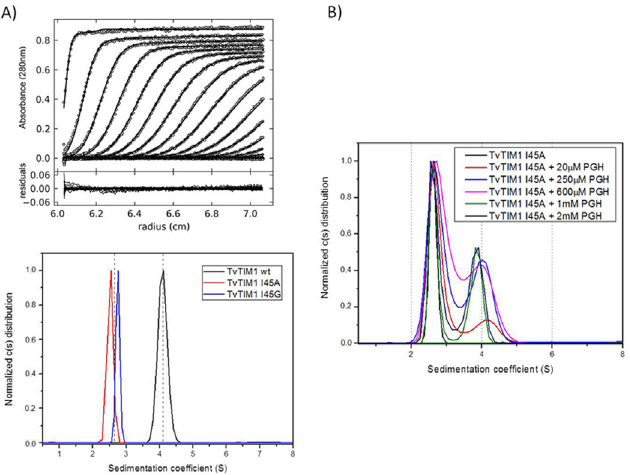
Fig 9. Substrate dependent dimerization of monomeric TvTIMs. (A) Trace of absorbance at 280 nm of TvTIM1 during Sedimentation Velocity experiment at the upper panel followed by the residuals bitmaps. Symbols correspond to experimental data and lines are the results fitted to the Lamm equation using Sedfit [28]. The lower panel shows continuous (c(s)) distribution of wild-type TvTIM1 (black curve) and monomeric mutants I45A (red) and I45G (blue). The left dashed line indicates monomer position whereas the right one indicates dimer. (B) Oligomeric states of I45A mutant in the presence of increasing concentration of PGH. Continuous (c(s)) distribution of I45A mutants in 20 mM Tris-HCl pH 8.0 plus 50 mM NaCl buffer. The distributions of protein without substrate are shown in black lines; the ones with 20 μ M of PGH are shown in red lines, with 250 μ M of PGH in blue lines, with 600 μ M of PGH in pink lines, with 1000 μ M of PGH in green lines and with 2000 μ M of PGH in dark blue lines.